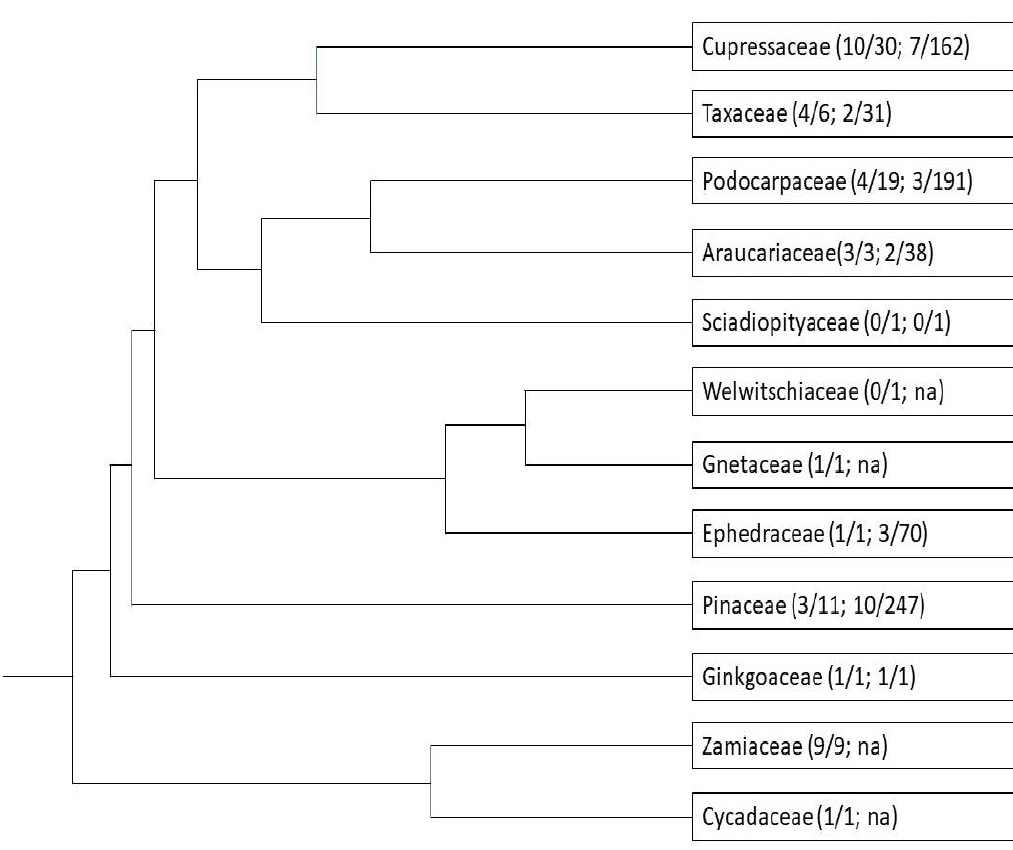
Figure 2. Epicormic resprouting in two species of the Cupressaceae. ( a ) Cryptomeria japonica . This species is used for bonsai and topiary and this example in a Japanese botanical garden had been pruned to form several leaders of equal dominance. ( b ) and ( c ) Sequoiadendron giganteum . This spe- cies is known to resprout from the stumps of younger trees, as is shown here for trees in an arbore- tum.